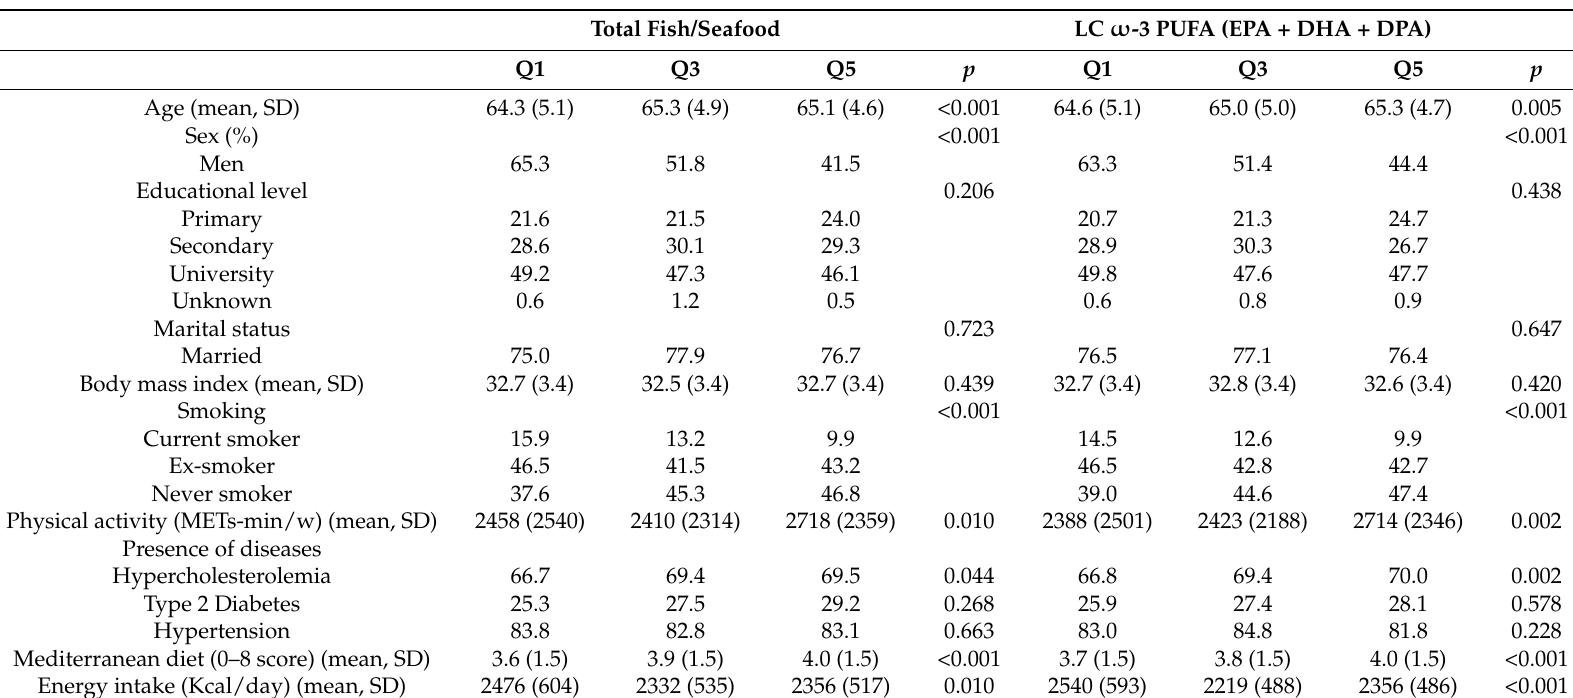
Table 1. Baseline characteristics of the participants from the PREDIMED-PLUS trial according to quintiles of consumption of fish/seafood and long-chain omega-3 fatty